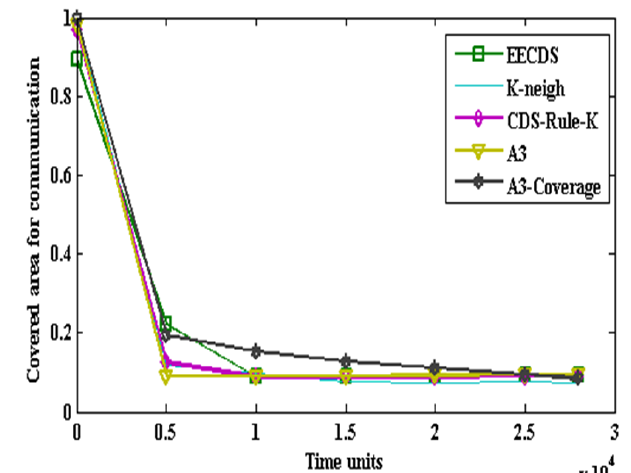
Figure 9. Network lifetime for communication coverage area